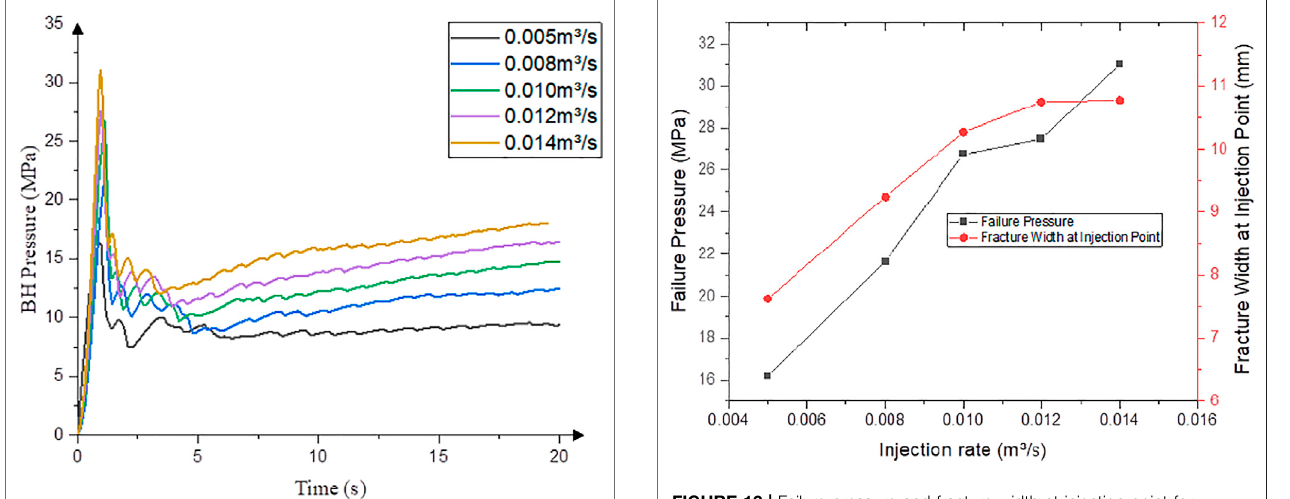
FIGURE 12 | Failure pressure and fracture width at injection point for various injection